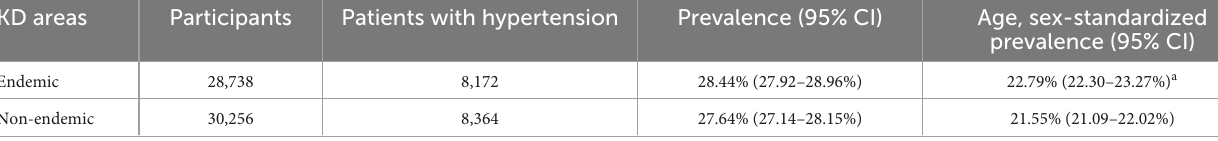
TABLE 1 Prevalence of hypertension in KD-endemic and non-endemic